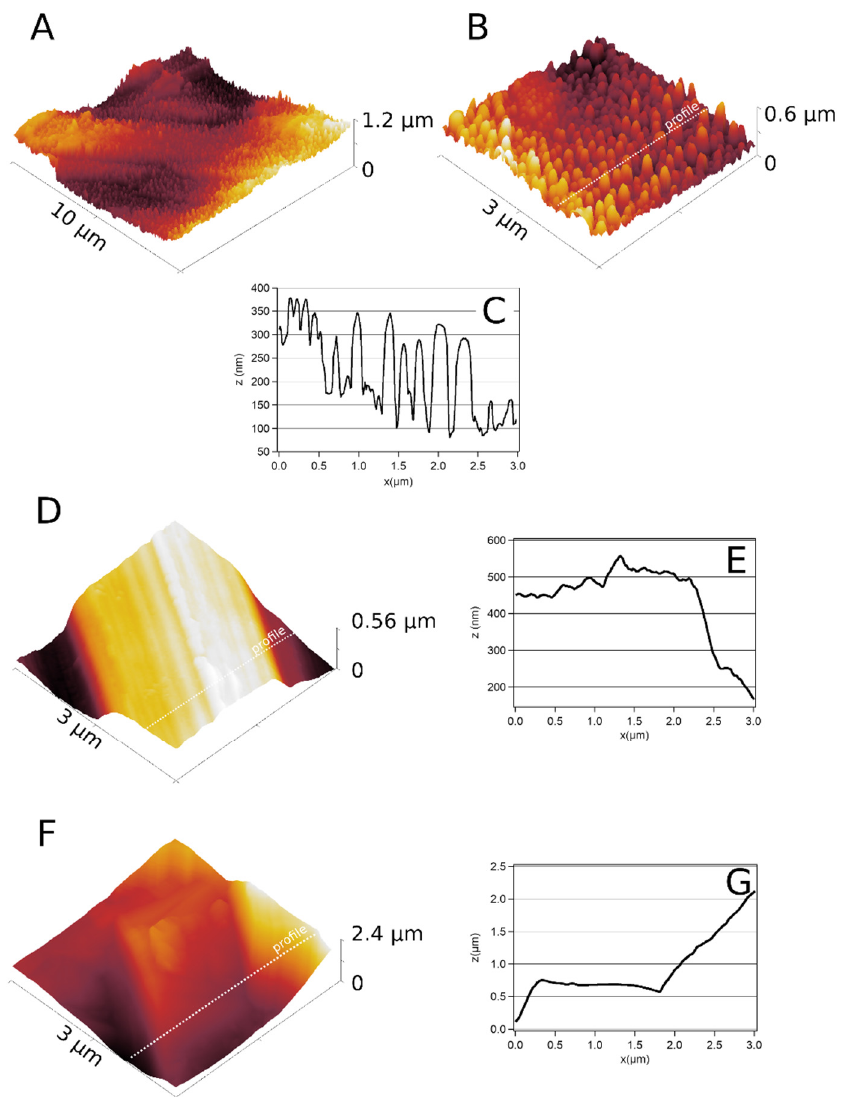
Figure 2. Intermittent-contact AFM topographic images taken with a sharp, high-aspect-ratio AR5- NCLR cantilever from Nanosensors ( A , B ). In both images, spikes of up to 400 nm are visible on the nanostructured titanium surface. Panel ( C ) shows the topographic profile along the line marked in ( B ). In comparison, ( D , F ) show (3 µ m × 3 µ m) topographic images and corresponding topographic profiles (( E , G ), respectively) of machined and SLA surfaces, respectively.